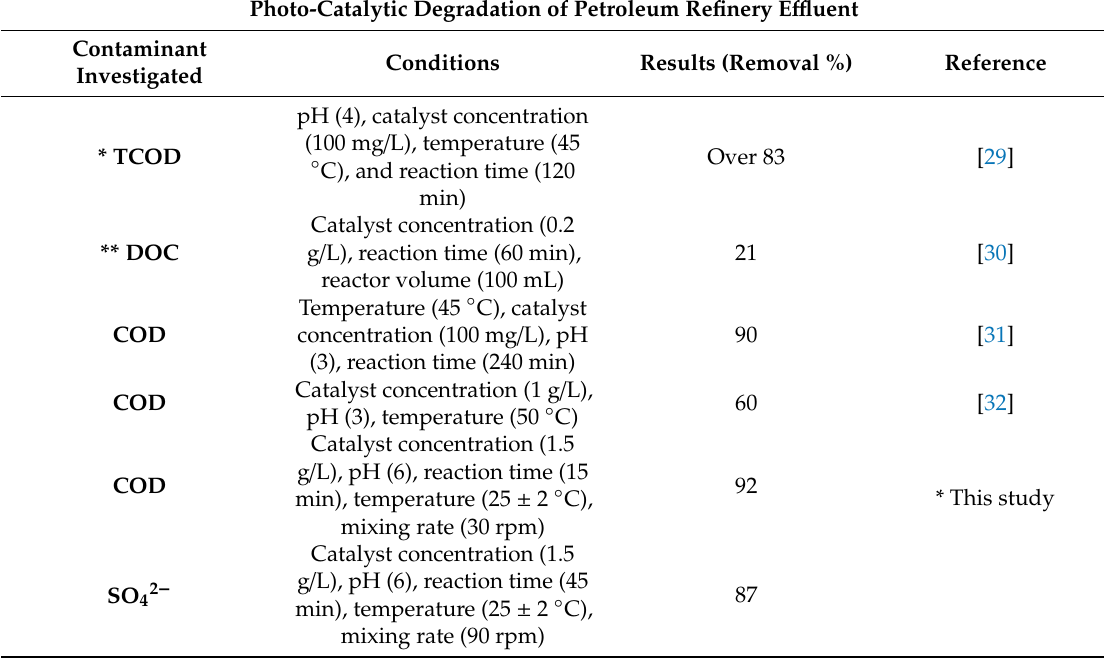
Table 9. Comparative studies on photo-catalytic degradation of petroleum refinery e ffl